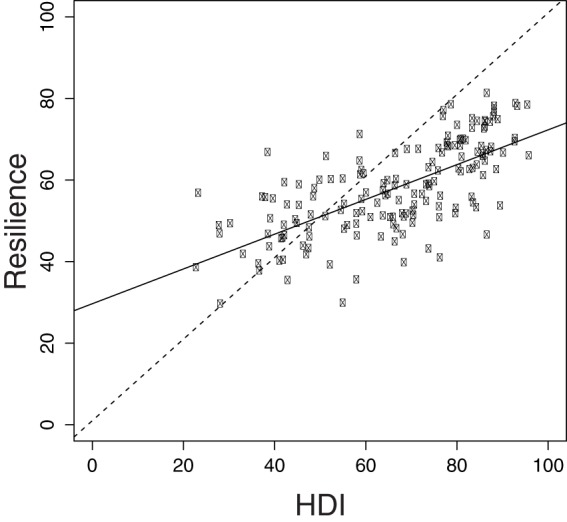
Relationship between Human Development Index (HDI) and resilience scores.For the HDI, raw scores were multiplied by 100 to facilitate comparison. Solid lines are the regression lines (HDI vs. Resilience: R-squared  = 0.46; p-value <0.0001). Dashed line is the 1:1 positive relationship.